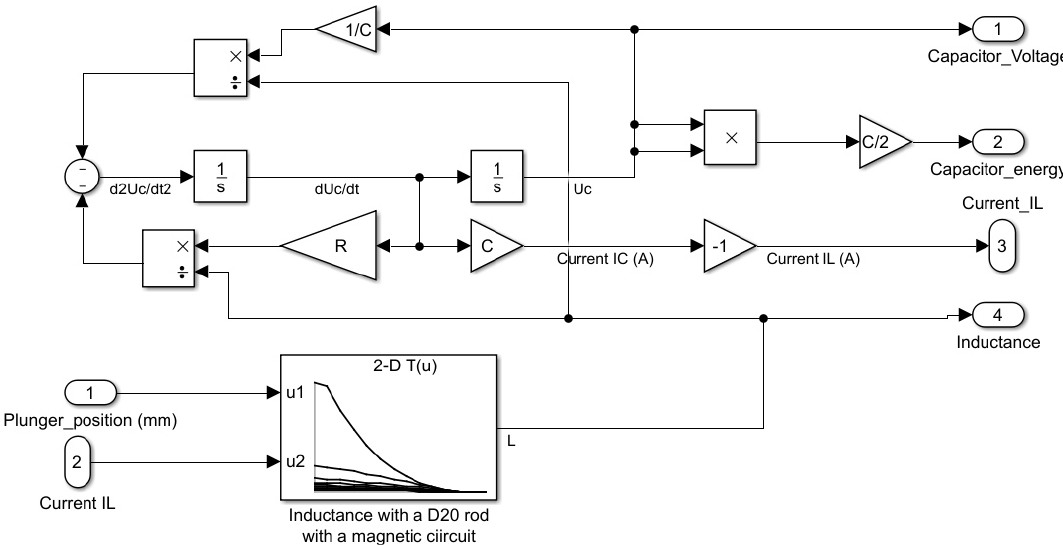
Figure 10. Electrical part of the coil gun model.